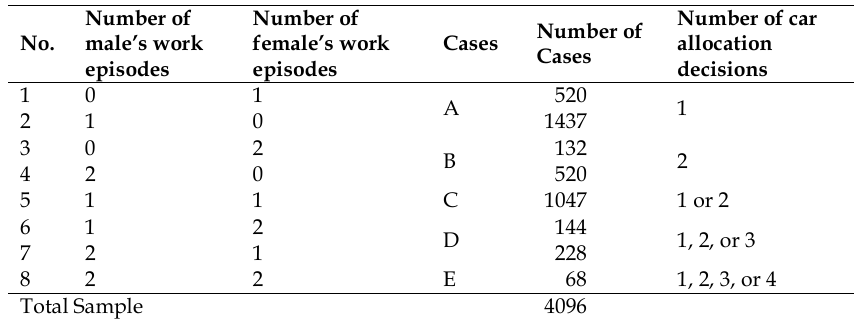
Table 1. Defining Car Allocation Decisions in Households